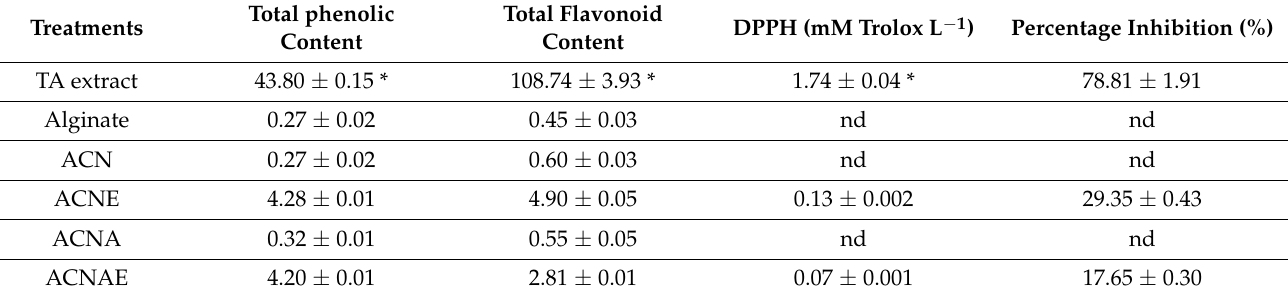
Table 3. Total phenolic and flavonoid content and antioxidant activity for the NFC-based aerogels and their isolated phases.